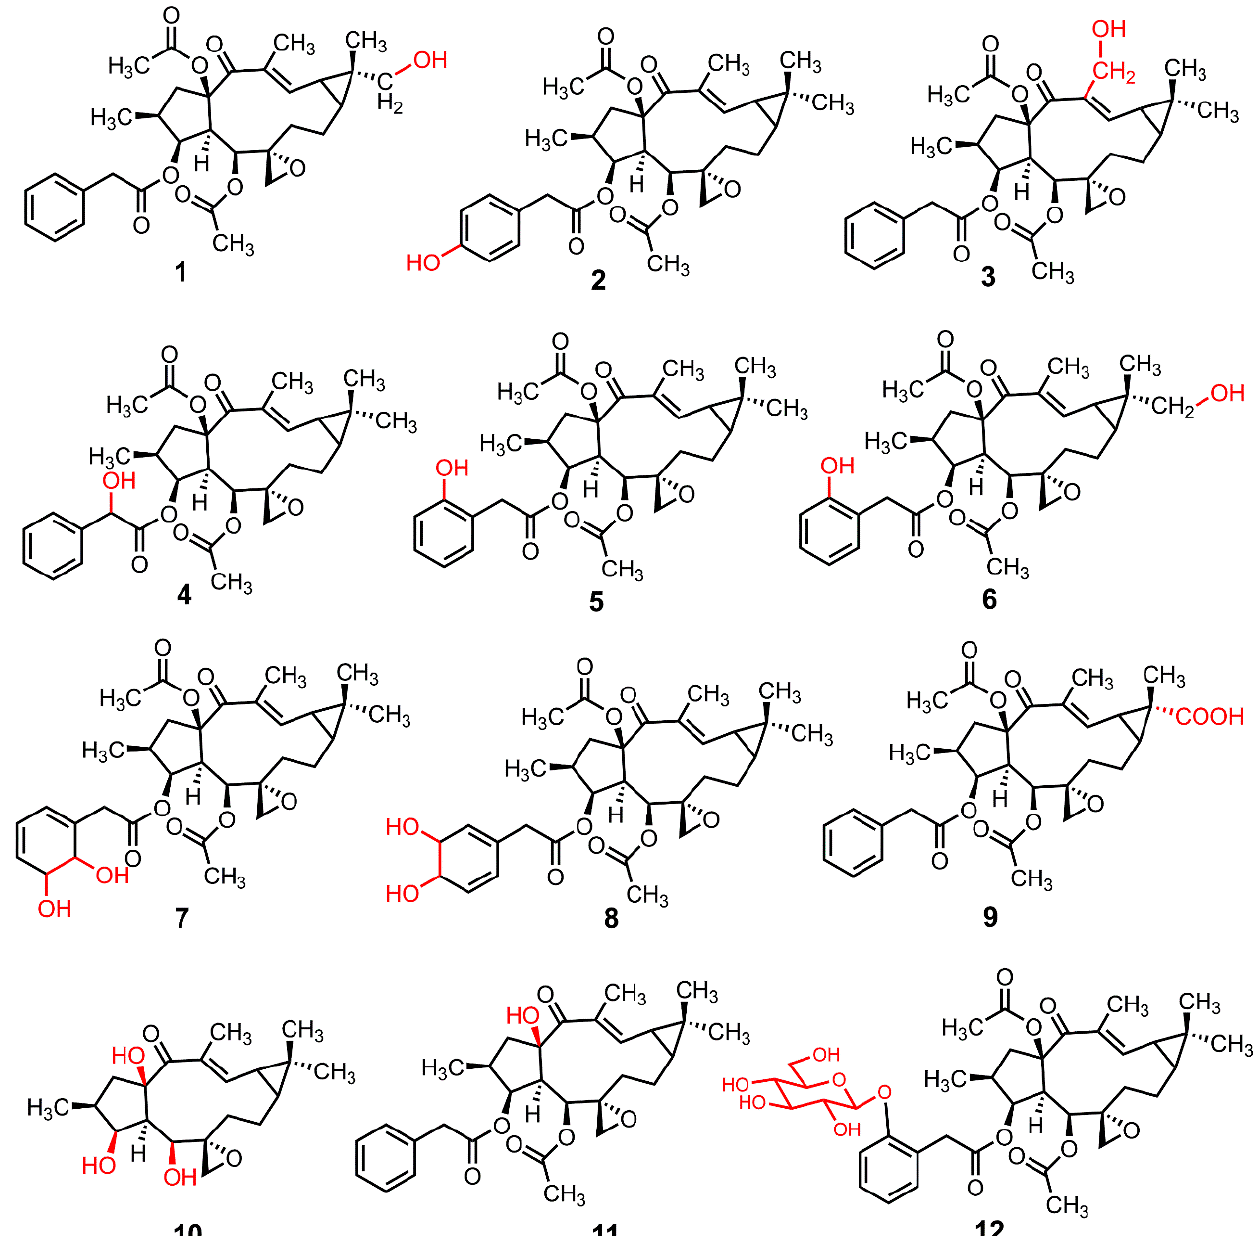
Figure 5. The structures of euphorbiasteroid and its transformation products. Compound 3 , a white powder, had an optical rotation of [ α ] 20 +63.97 ◦ ( c 0.130, MeOH). D Its molecular formula was deduced to be C 32 H 40 O 9 from the [M + H] + ion at m / z 569.2746 in HRESIMS. Compound 3 was proposed to be a hydroxylated product of euphorbiasteroid due to its molecular weight being 16 mass units more than that of euphorbiasteroid. When comparing its 1 H and 13 C NMR data with those of euphorbiasteroid (Tables 1 and 3),